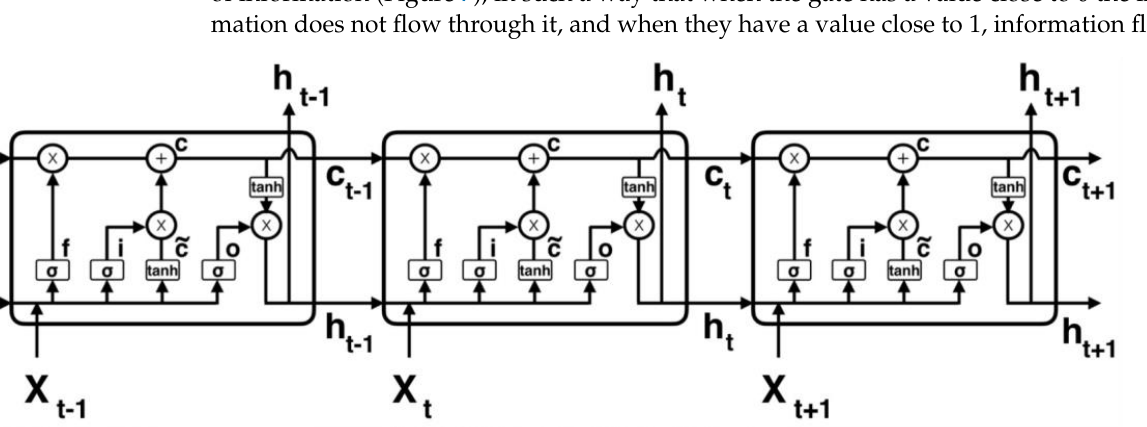
Table 3. Comparison of models.